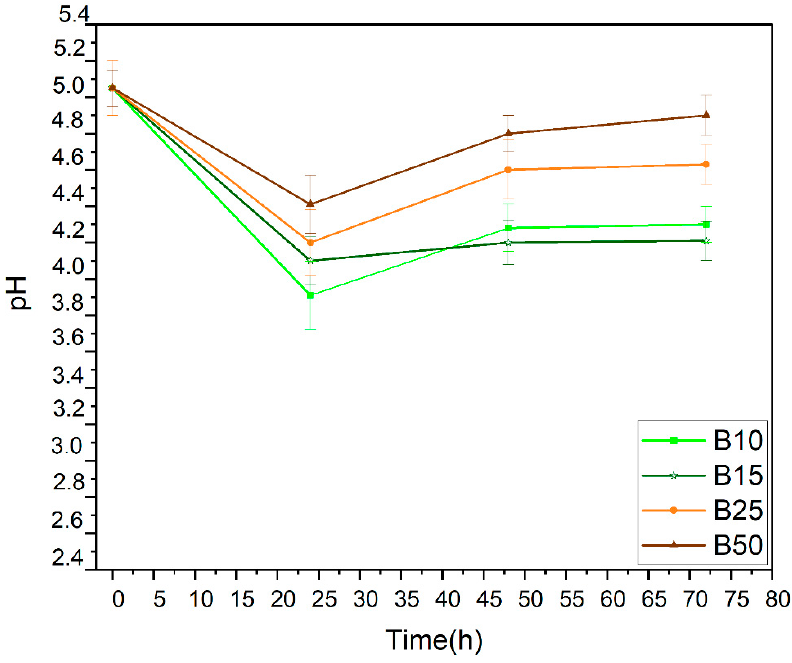
Figure 3. pH evolution during anaerobic fermentation.